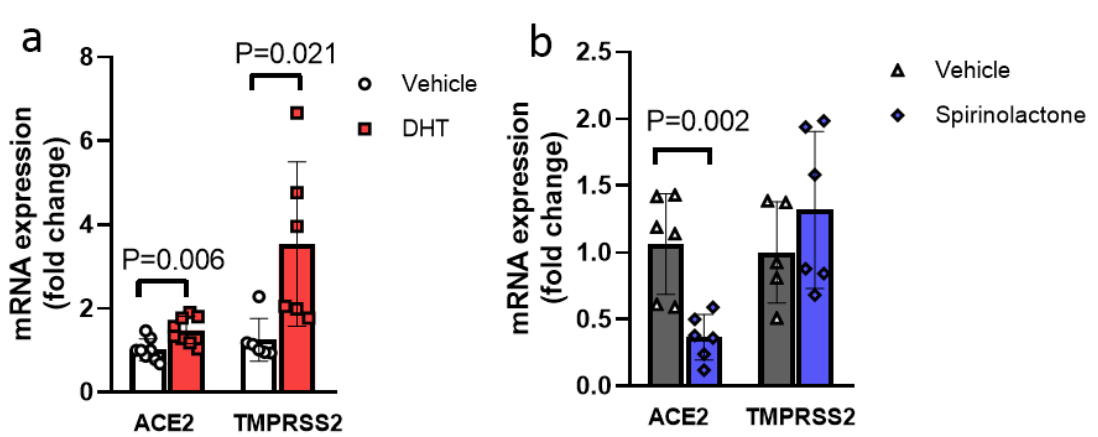
Figure 3. Effects of DHT and spironolactone on endothelial ACE2 and TMPRSS2 transcript expression in ECs. ( a ) DHT (500 nM) significantly increased ACE2 and TMPRSS2 transcript expression as compared to its vehicle. ( b ) Spironolactone (10 mM) treatment significantly reduced ACE2 transcript expression as compared to its control vehicle without affecting TMPRSS2 transcript expression in ECs in vitro (n = 6–8). Data were analyzed by two-sided unpaired t -test. p < 0.05 was defined to be statistically significant. All data are expressed as mean ± s.d.